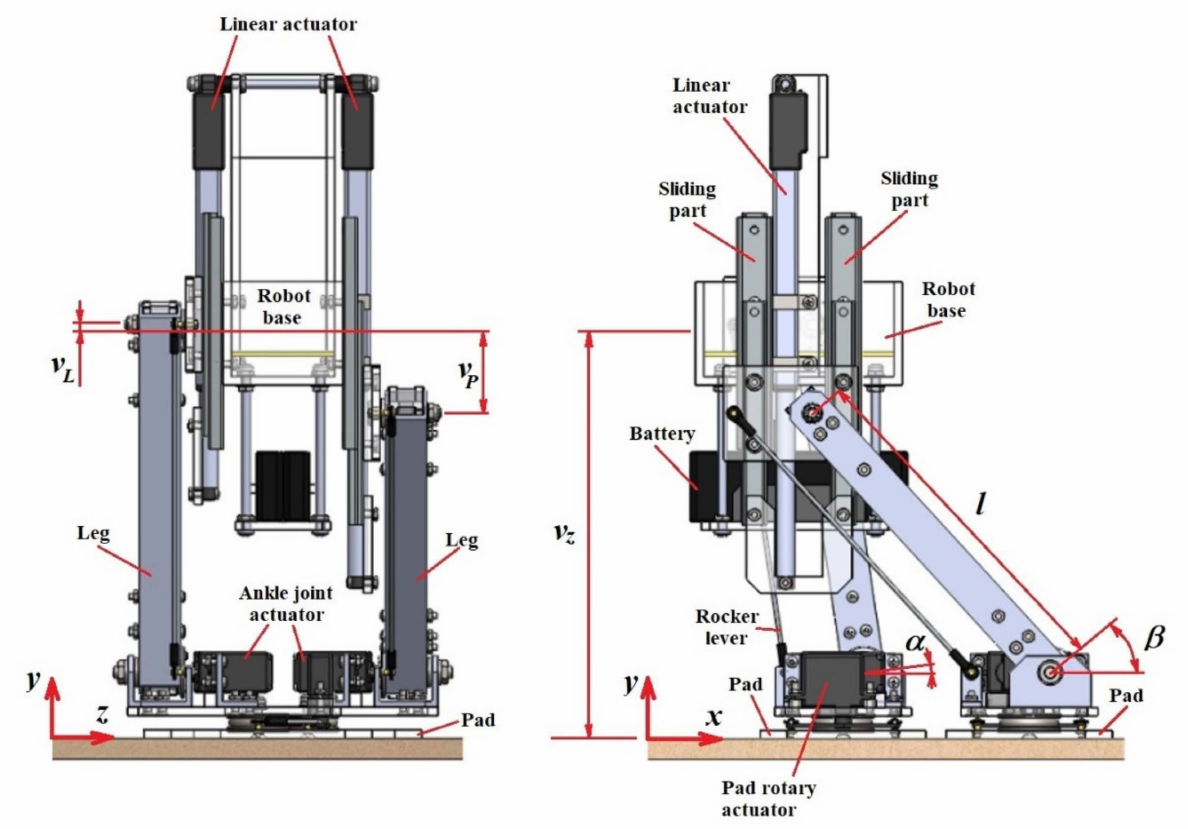
Figure 3. The final design of a biped walking